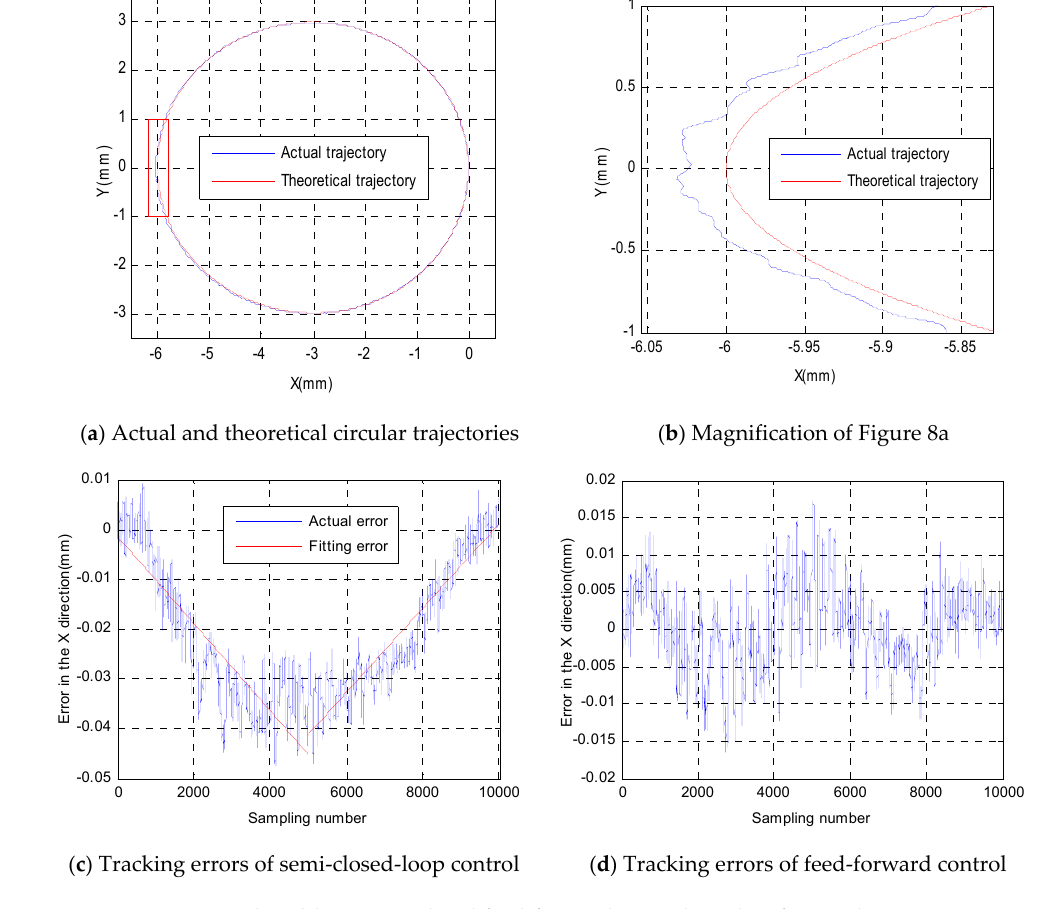
Figure 8. Semi-closed-loop control and feed-forward control results of a circular trajectory.